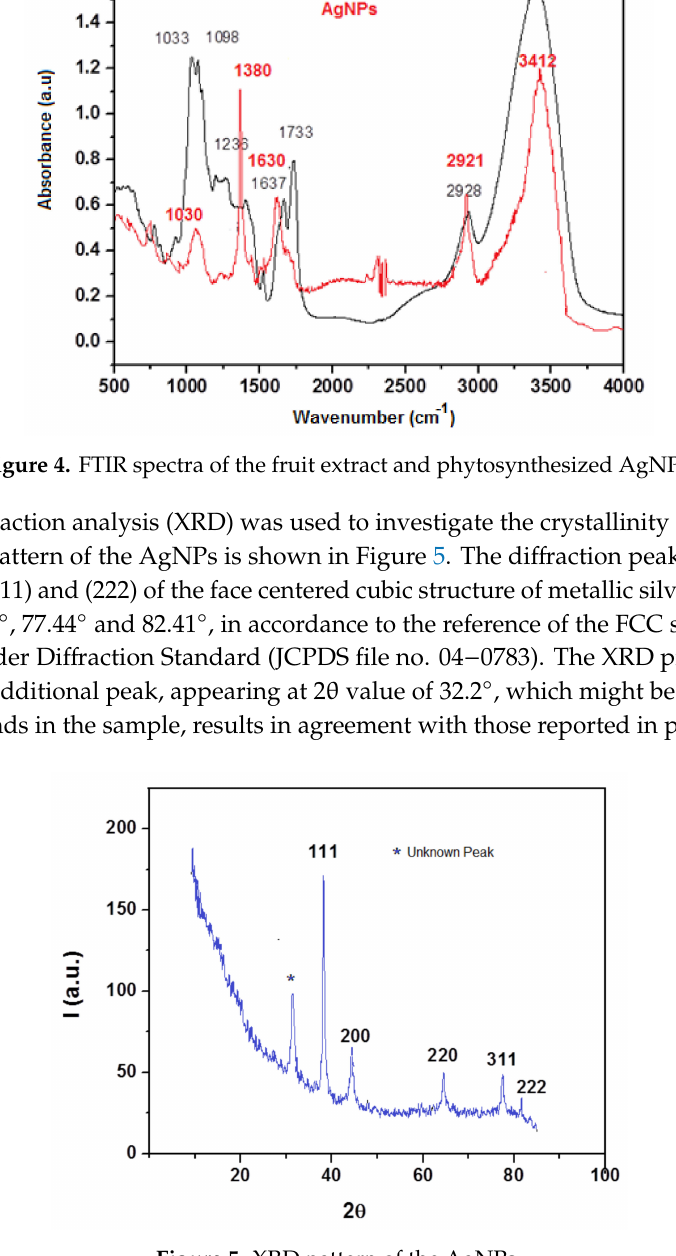
Figure 5. XRD pattern of the